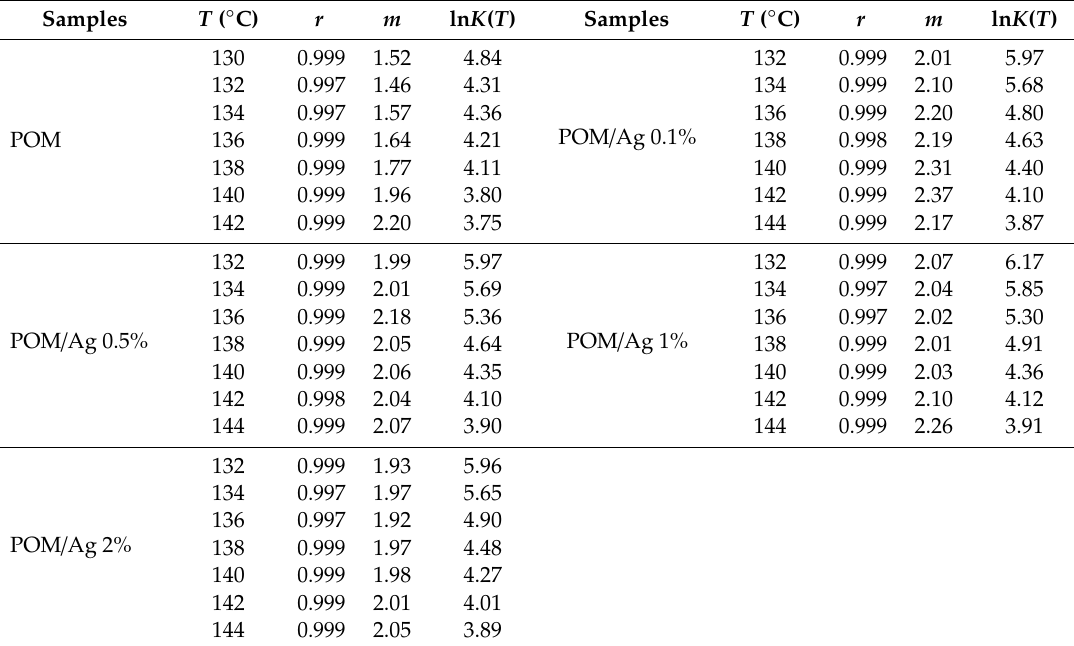
Table 3. Parameters of Ozawa analysis for the POM / Ag nanocomposites. Samples